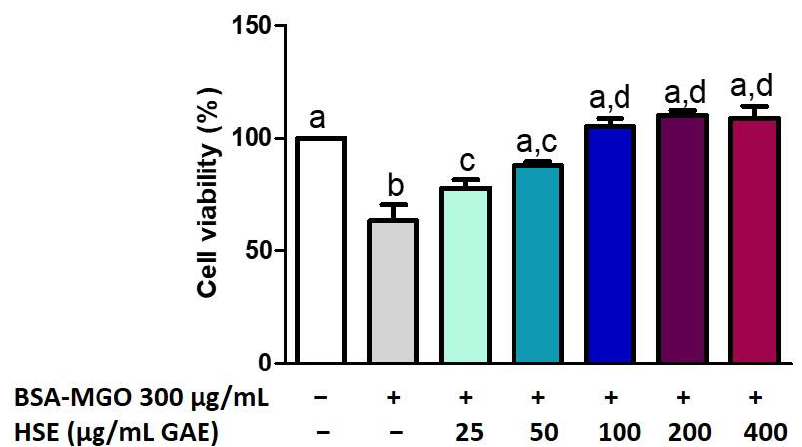
Figure 5. Cell viability after HSE co-treatment with BSA – MGO on THP-1 macrophages (M0). MTT assay was performed at 24 h post-treatment. Cell viability was expressed as % of control (non- treated). All data represent the means of at least three replicates ± standard deviation. The analysis of variance was carried out using the one- way ANOVA test followed by the Tukey’s multiple com- parison test: letters denote significant differences among samples.